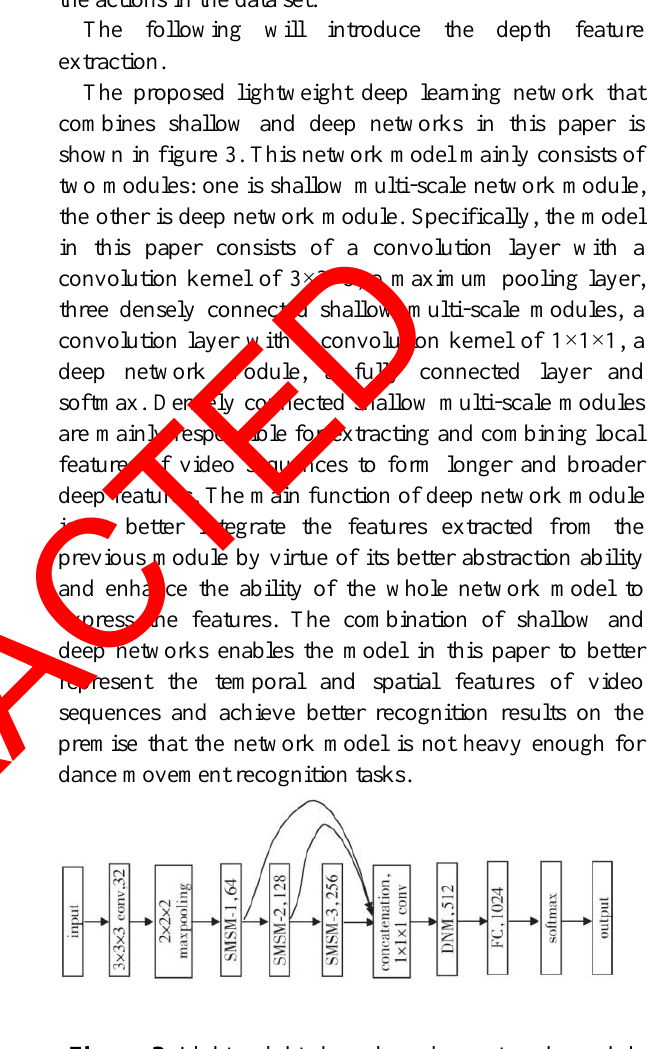
Figure 3. Lightweight deep learning network model combining shallow and deep networks, SDNet